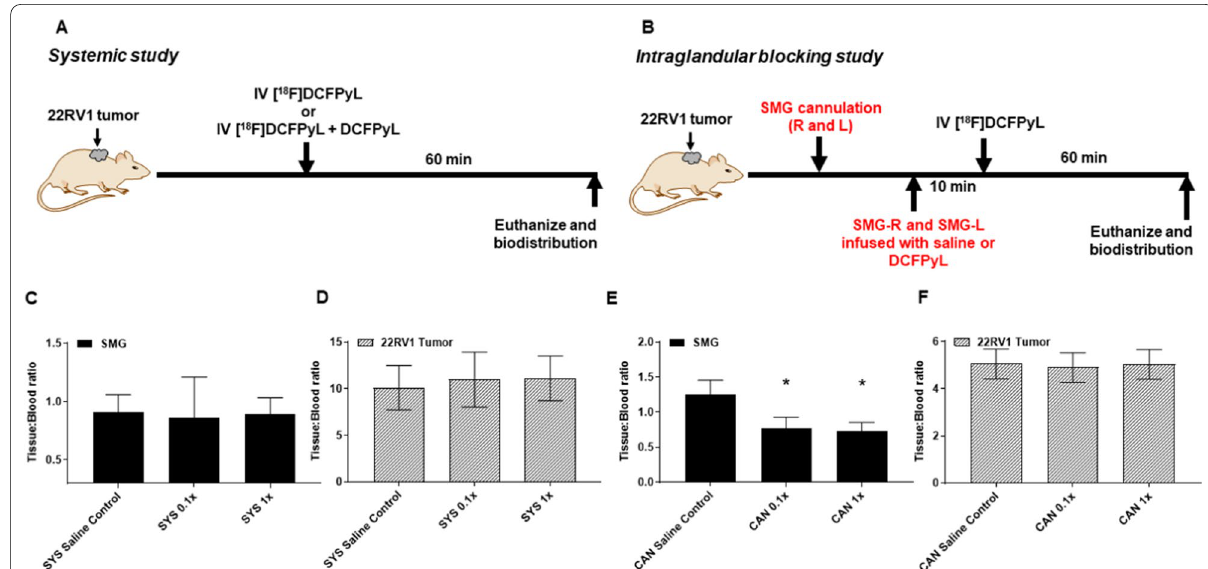
Fig. 3 Experimental design for systemic study (SYS group) and intraglandular blocking study (CAN group) in the validation 22RV1 tumor-bearing cohort ( a , b ). The tissue/blood ratios of [ 18 F]DCFPyL in submandibular salivary glands (SMG) and the tumor at 1 h post-injection are shown for the SYS group (panels c , d ) and for the CAN group (panels e , f ), respectively. Mice were injected either with 50 µl of saline control or with “cold” DCFPyL at 0.1 or 1 molar equivalent of the systemically injected “hot” [ 18 F]DCFPyL dose. Each value in the graphs represents mean tissue/ × × blood ratios SD, n 5–7 for each group, with statistically significant results ( P < 0.05) indicated by asterisk. Mice in the CAN 0.1 ± = demonstrate statistically significant local blocking at the SMG with no reduction in [ 18 F]DCFPyL uptake at the tumor